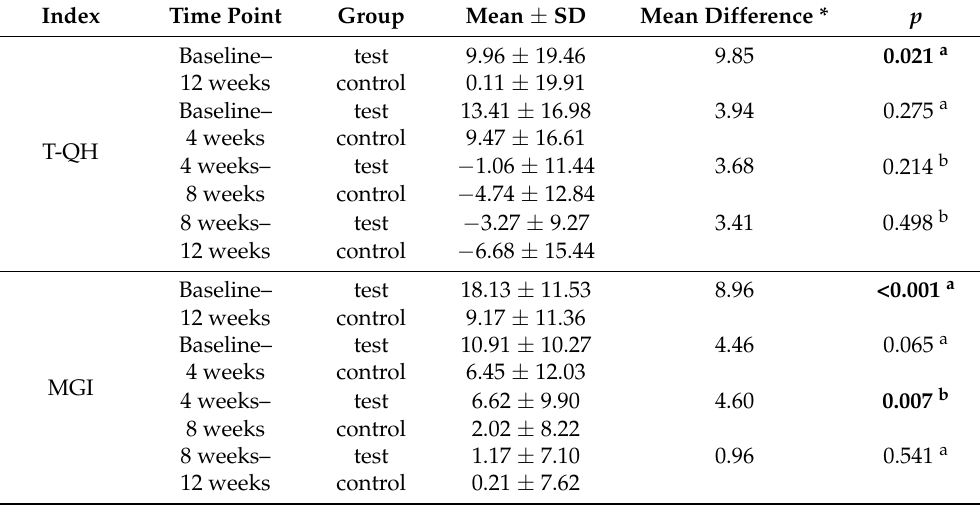
Table 3. The reduction in percentage of the periodontal indices for two groups at follow-up (full analysis